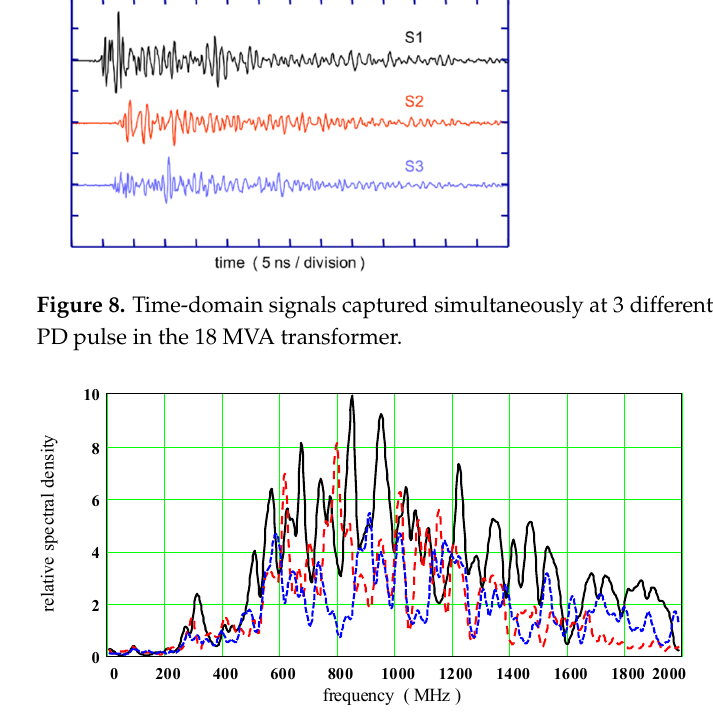
Figure 9. Comparing frequency spectra of the 3 PD signals shown in Figure 8.